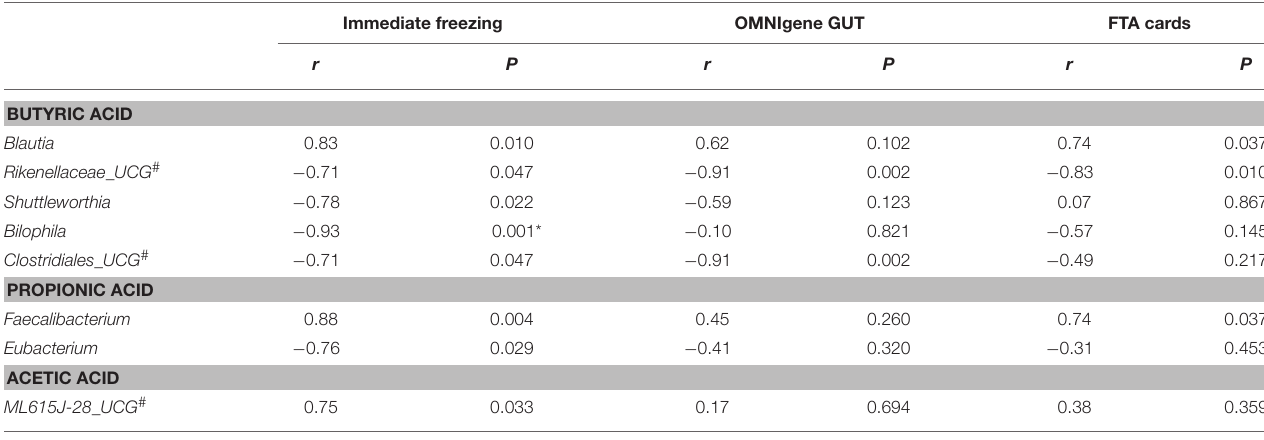
TABLE 2 | Short chain fatty acids associated taxonomy: Genera which were significantly correlated with butyric acid, propionic acid and acetic acid, by Spearman correlation coefficients. Immediate freezing OMNIgene